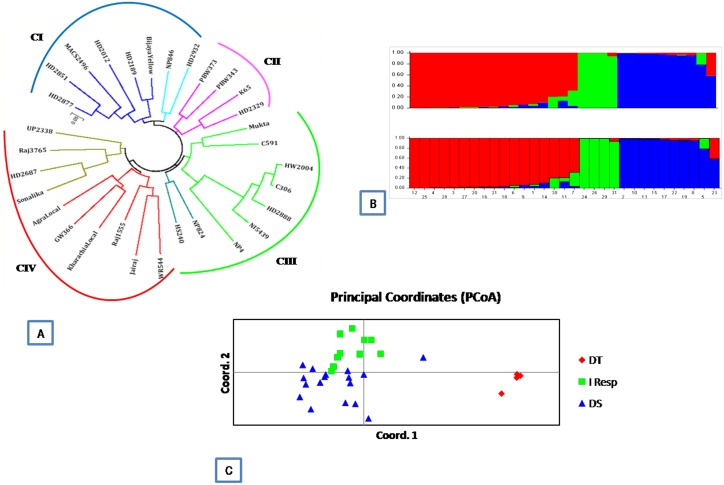
Categorization of 31 wheat genotypes revealed by 30 SSR markers.(A) UPGMA tree constructed using Jaccard’s similarity coefficient; (B) Three subgroups formed from STRUCTURE analysis, Model based population structure plot for each variety with K = 3. Color codes are as follows: Population I red, Population II green, population III blue; (C) Principal coordinates analysis The genotypes are grouped as DT = drought tolerant genotypes, Intermediate Responsive = moderate tolerant and sensitive genotypes and DS = drought sensitive genotypes.